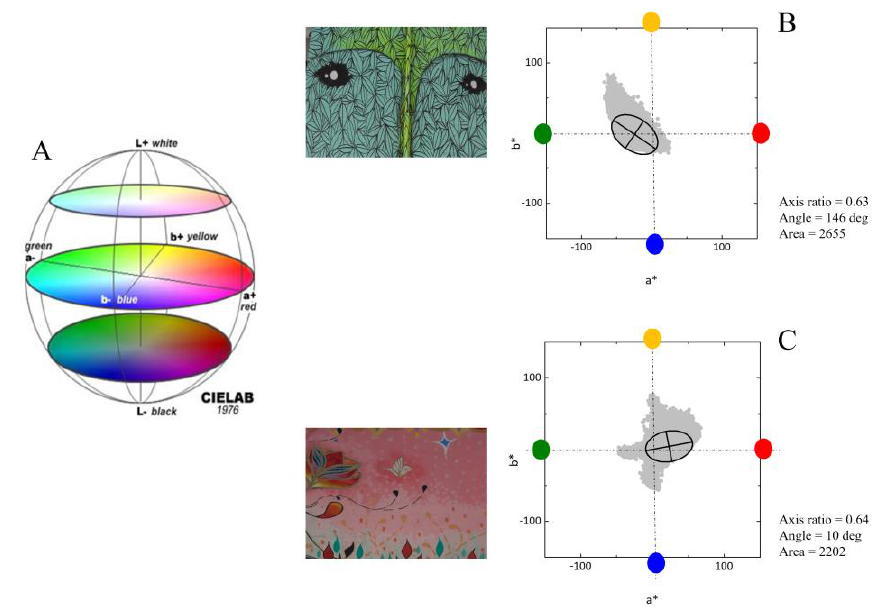
Figure 3. ( A ) The color space CIELAB. ( B , C ) The representation of the color gamut of two examples of graffiti in the color plane of the color space. The color of each direction—red, green, yellow and blue—is indicated in the graphs. The upper graffiti ( B ) has more greens and yellows, and the lower graffiti ( C ) has more reds, properties that define how the color gamut is represented in the color space. To characterize the geometry of the color gamut with few parameters we fitted ellipses to the gamut such that the major and minor axes were aligned with the principal directions. The axes sizes were twice the standard deviation. The axis ratio was the result of the minor divided by the major axis. The angle was defined between the major axis and the positive a* axis. The area is proportional to the number of colors in the graffiti.